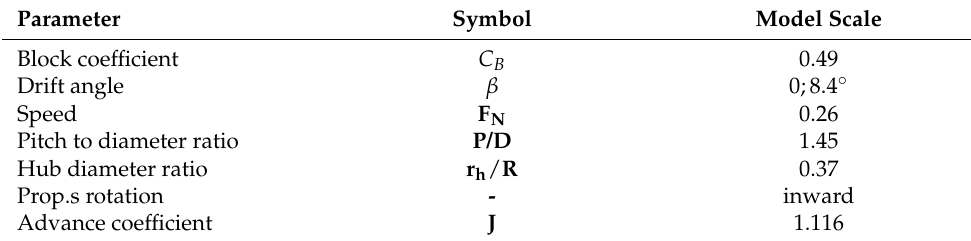
Table 1. Ship and propeller models: main